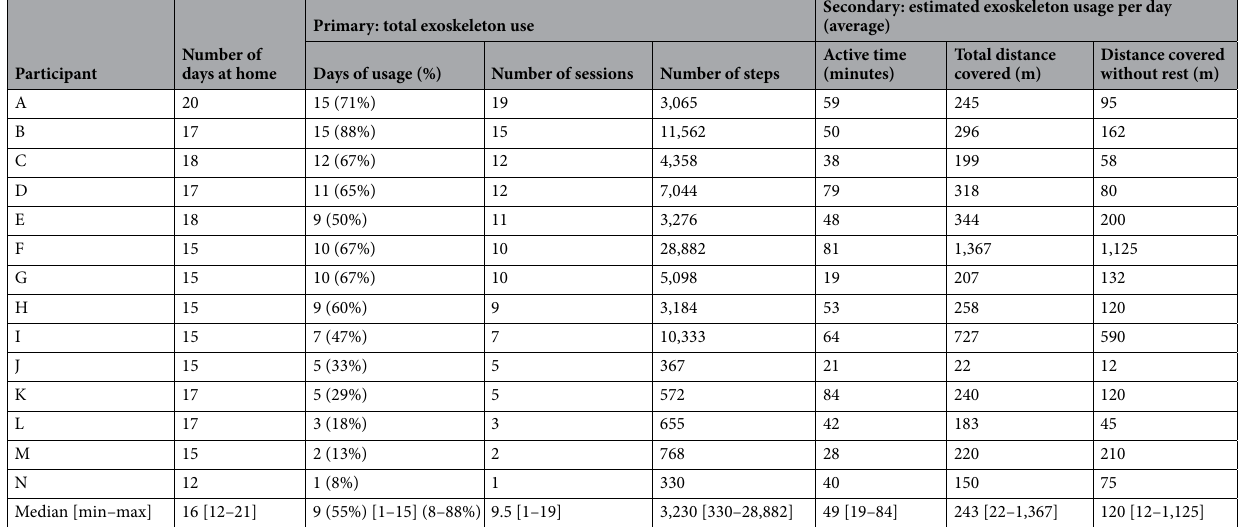
Table 3. Amount of exoskeleton use during the period of home and community use.